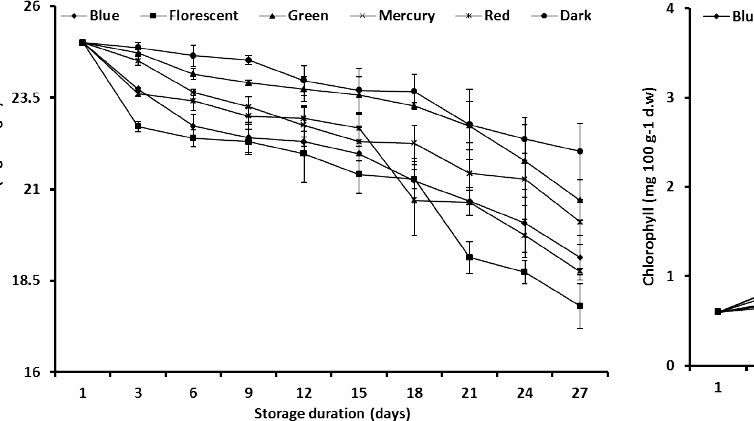
Fig. 5: Effect of different light sources on chlorophyll. Vertical bars show ±SE of means (n=3). The interaction between storage duration and light sources was significantly different at p ≤